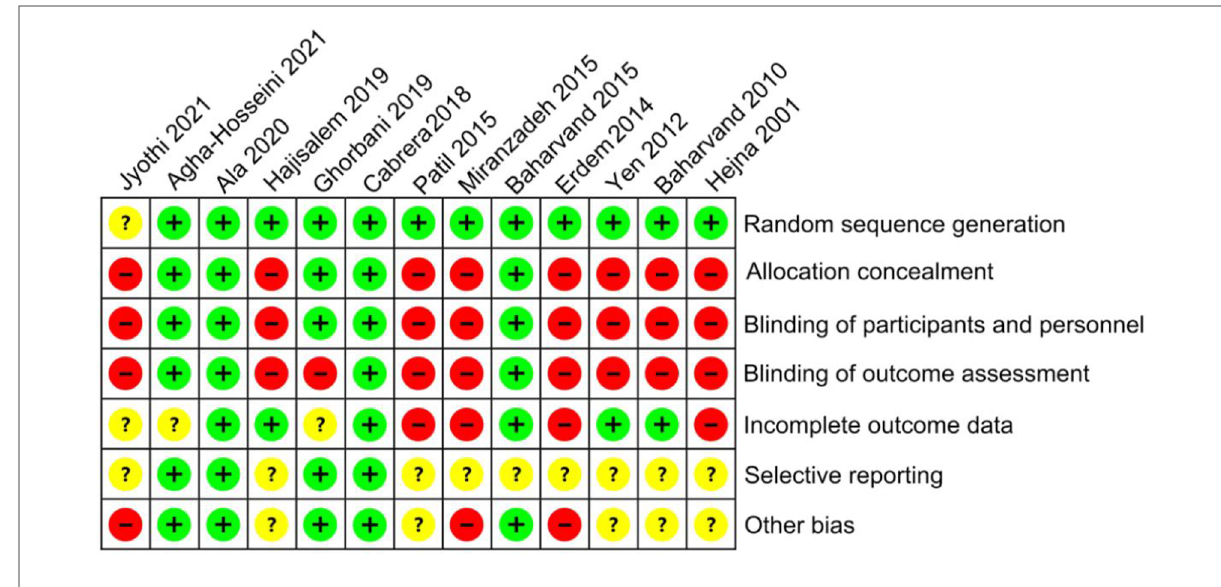
FIGURE 4 Risk of bias assessment of the 13 RCTs included in this Bayesian network meta-analysis.